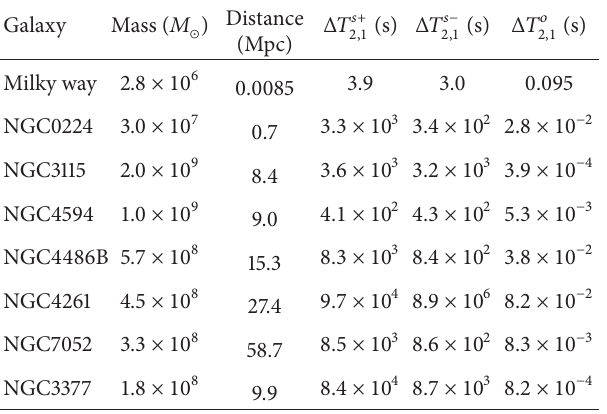
Table 10: Estimation of time delays of the supermassive BHs located at the center of galaxies for phantom global monopole ( 𝜉 = −1 ) with 𝜂 = 0.25 .